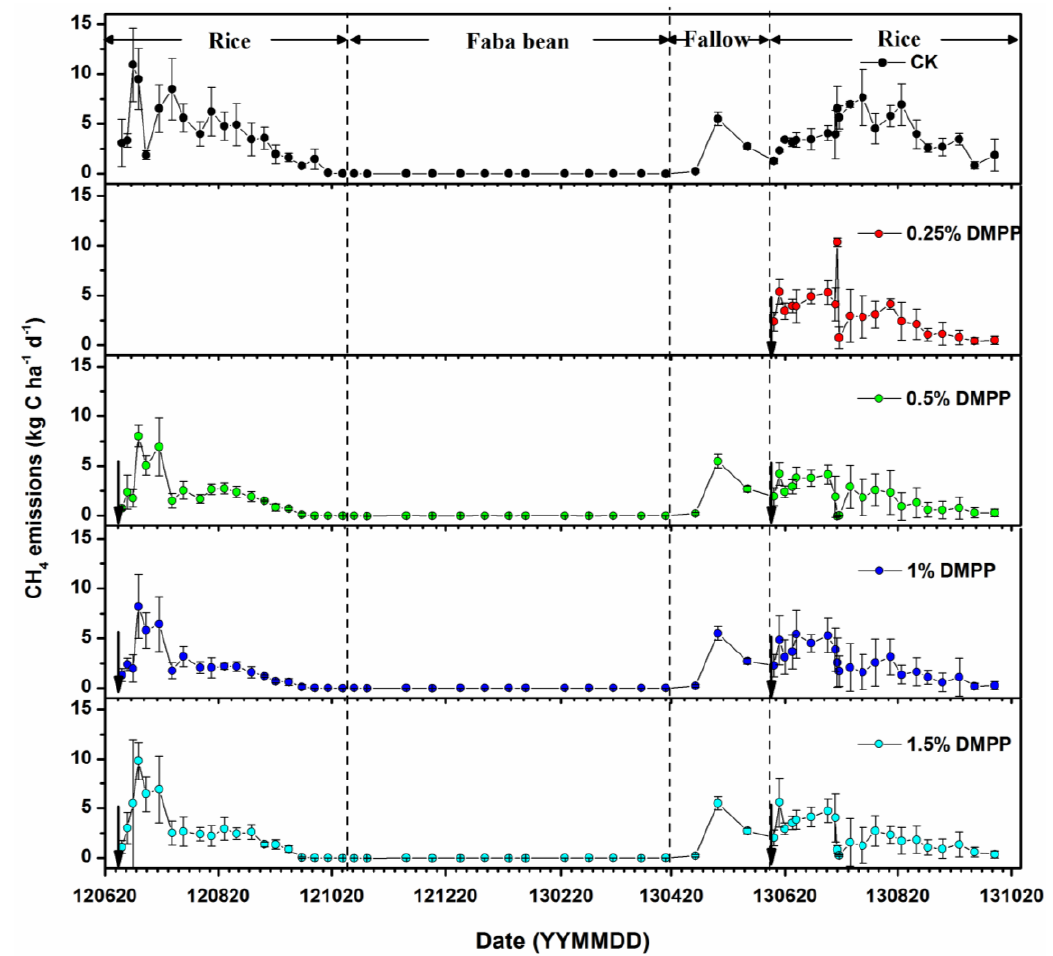
Figure 1. CH 4 emissions under different DMPP treatments.